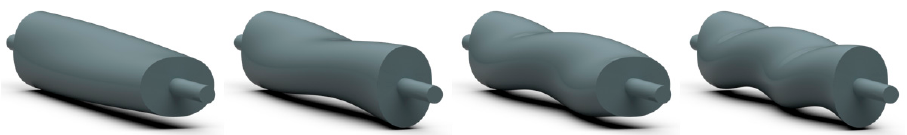
Figure 6. Rotors with a single roundness component that includes only the second component. The phase of the compo- nent varies continuously along the rotor. From left to right, the component rotates 90°, 180°, 270°, and 360°. The phase shift is distributed evenly along the